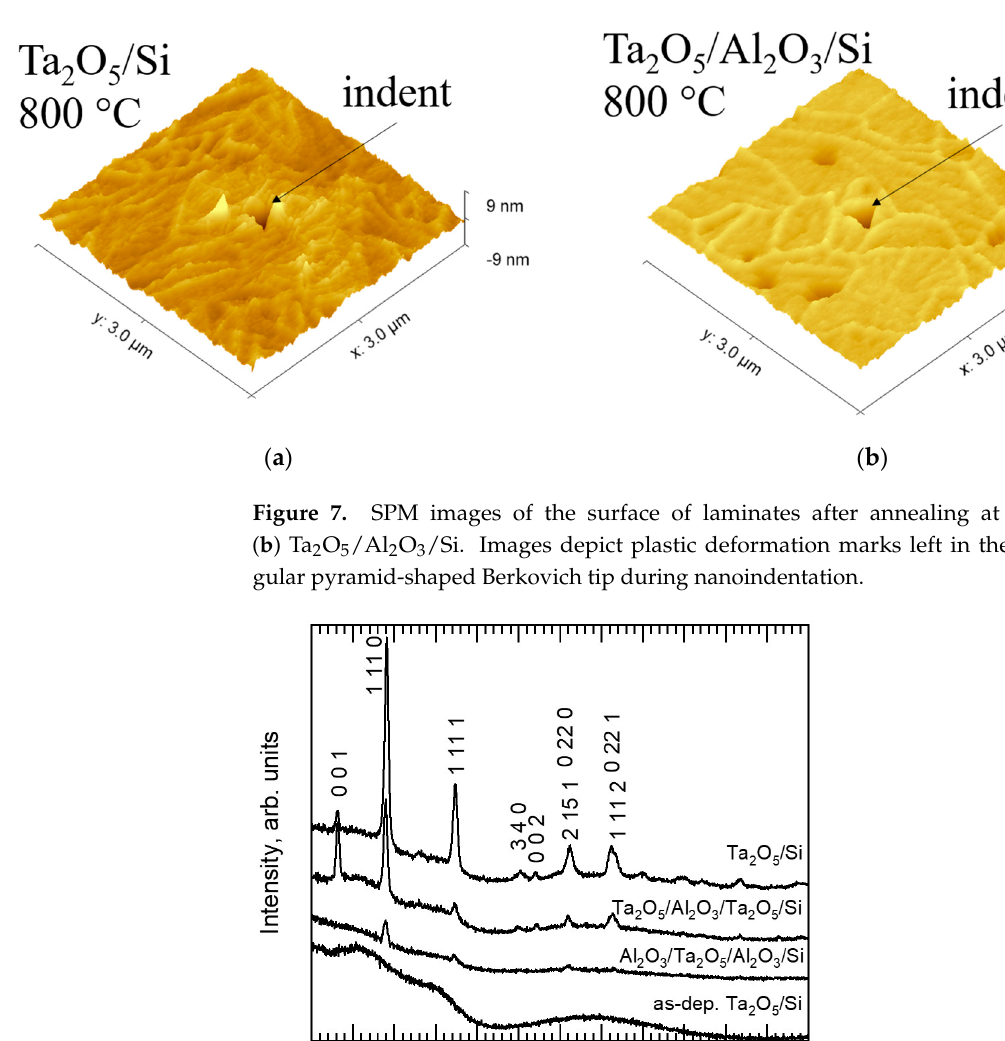
Figure 6. SEM images of the surface of laminates after annealing at 800 °C: ( a ) Ta 2 O 5 /Si; ( b ) Ta 2 O 5 /Al 2 O 3 /Si.